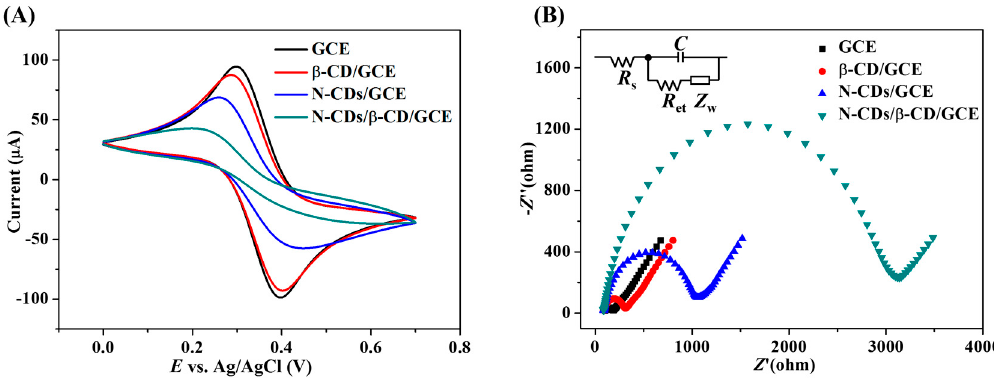
Figure 4. ( A ) CVs of bare GCE, β -CD/GCE, N-CDs/GCE and N-CDs/ β -CD/GCE in 5.0 mM[Fe(CN) 6 ] 3 − / 4 − solution containing 0.1 M KCl; ( B ) Nyquist plots of bare GCE, β -CD/GCE, N-CDs/GCE and N-CDs/ β -CD/GCE in 5.0 mM [Fe(CN) 6 ] 3 − / 4 − solution containing 0.1 M KCl with the frequencies swept from 10 5 Hz to 0.1 Hz. Insert is the equivalent circuit for fitting the plots. R s : solution resistance; R et : electron transfer resistance; C : interfacial double layer capacitance; Z W : Warburg impedance.